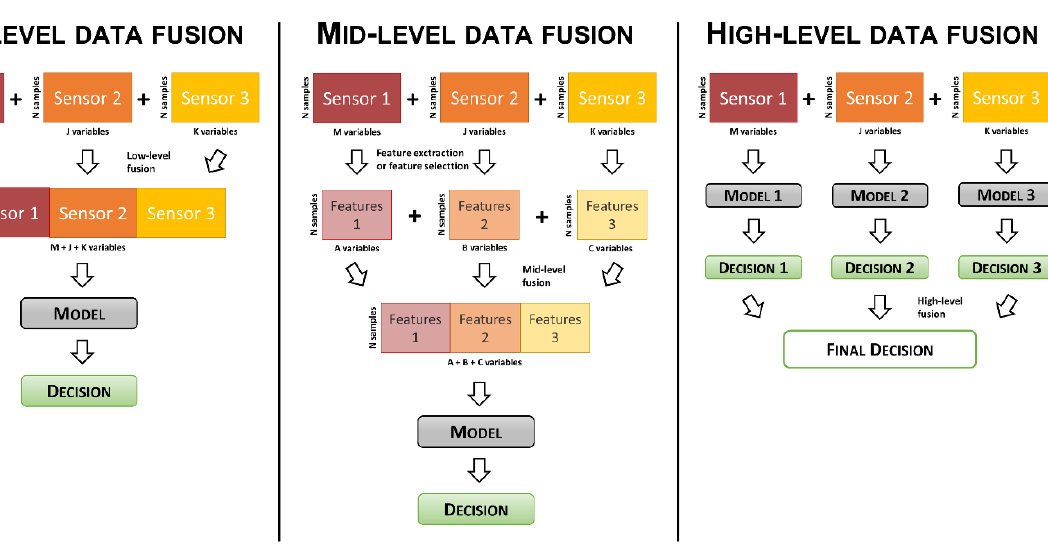
Figure 2. Schematic representation of the different data-fusion strategies.